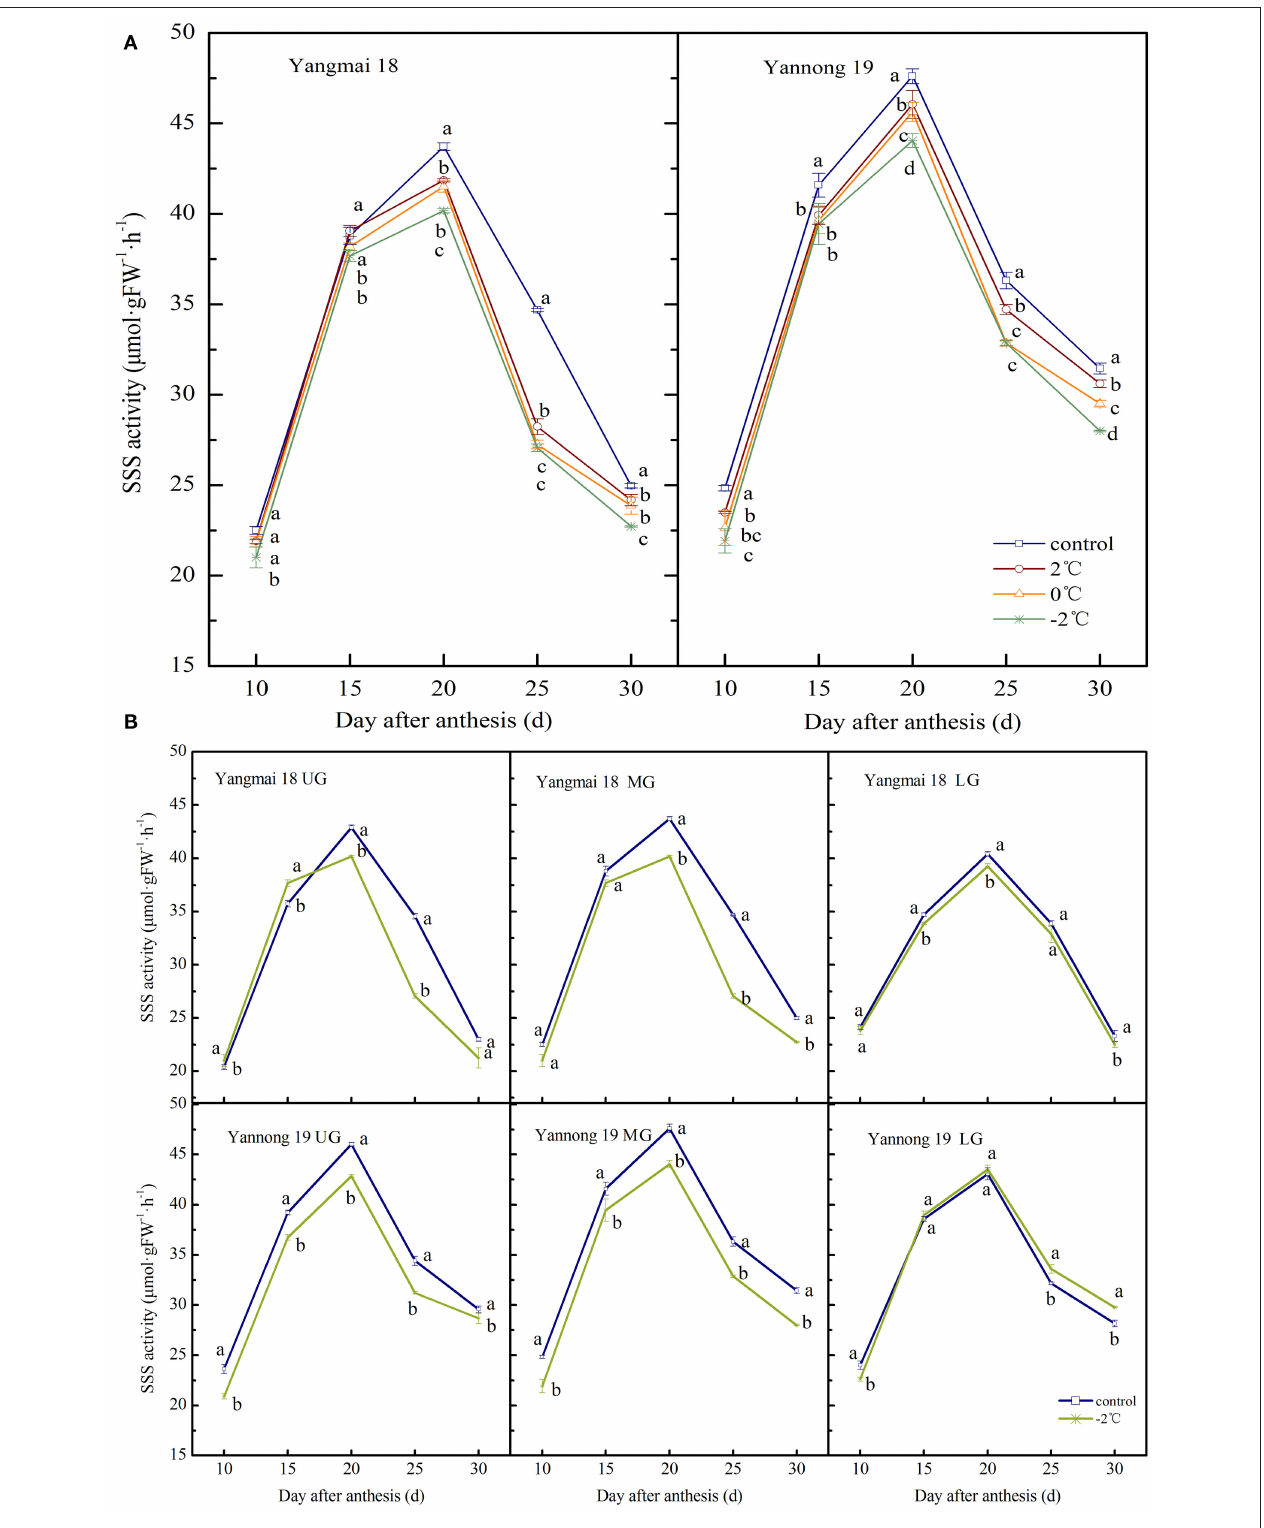
FIGURE 4 | The effect of short-term LT at the booting stage on the activity of soluble starch synthase in the wheat grain of the middle spikelets (A) and different position spikelets (B) . UG, grains in the upper spikelets, MG, grains in the middle spikelets, LG, grains in the lower spikelets. At the booting stage, the wheat